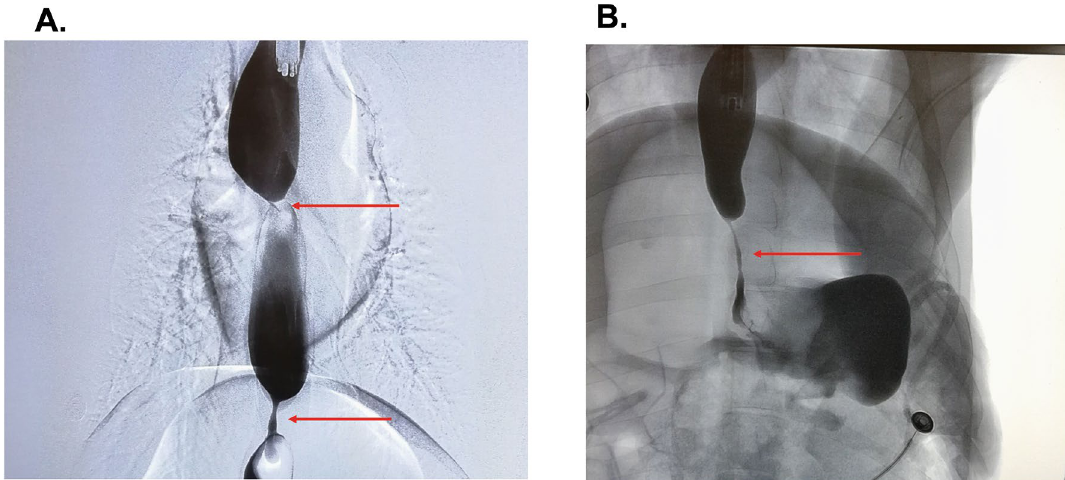
Figure 3. Fluoroscopy at day 28 showing proximal and mid esophageal strictures. ( A ) Contrast injection from the proximal esophagus revealed two strictures. There was a 1 cm stricture at 30 cm (proximal, arrow) and another 3 cm stricture at 40 cm (mid, arrow) from the incisors. Note the upstream dilation of the esophagus as a result of the strictures. ( B ) Contrast injection revealing a uniform 5 cm distal esophageal stricture at 50 cm from the incisors. The diameter of the stricture was 0.5–1 mm. Note the contrast in the gastric fundus downstream from the stricture indicating that the stricture is not causing complete luminal